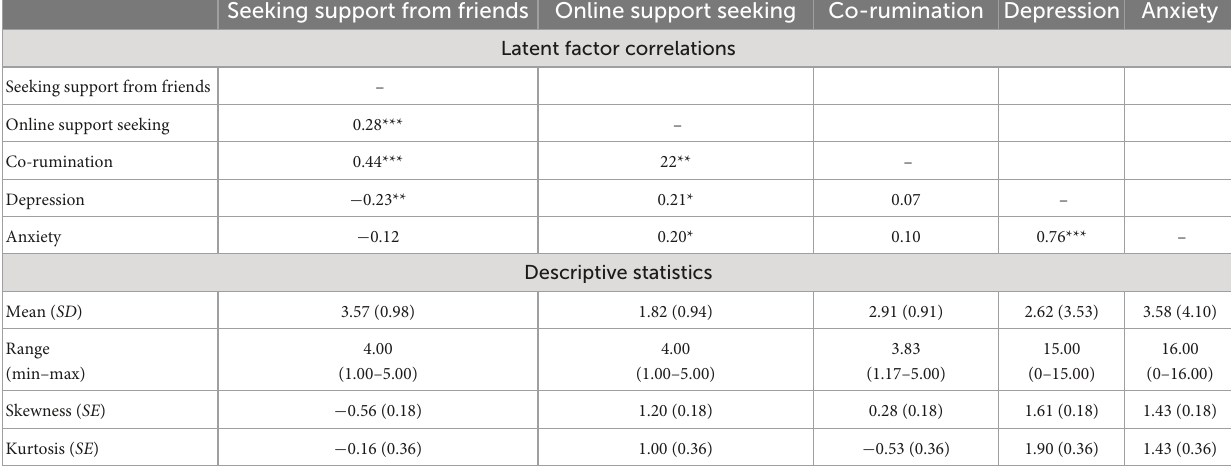
TABLE 2 Correlations between latent factors and descriptive